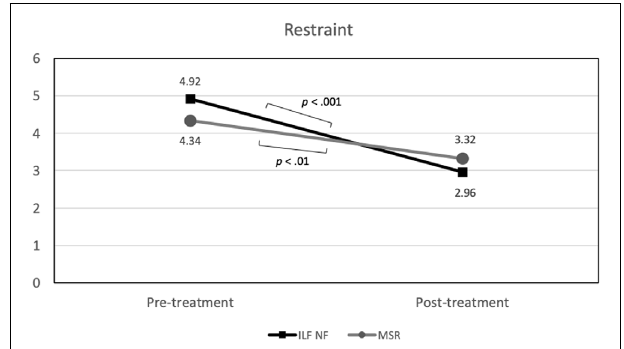
FIGURE 3 | Group × Time interaction effect on restraint (significant mean differences are indicated).